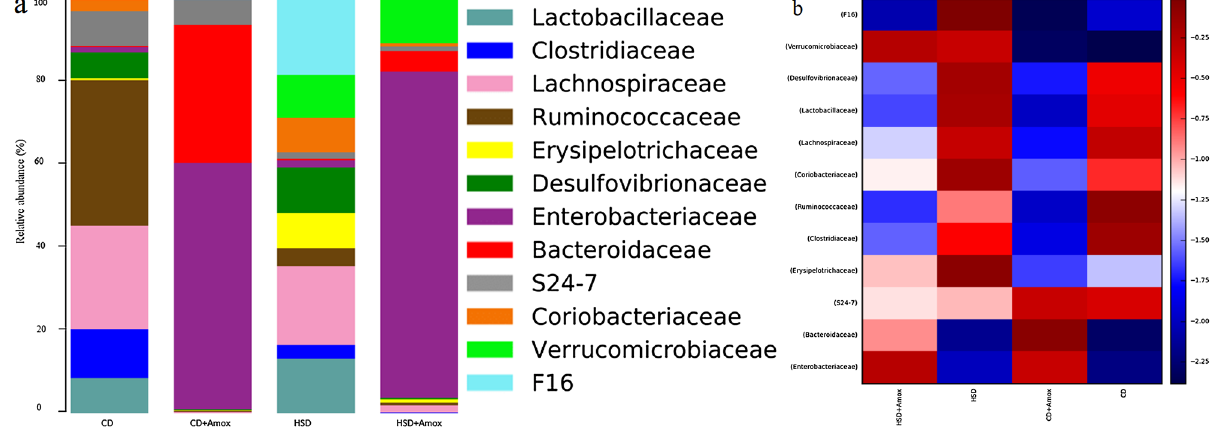
Figure 6. Bar chart ( a ) and heat map ( b ) showed the short-term effect of a high-salt diet (4% in chow) followed by Amoxicillin treatment on the relative abundance of the most represented family for each group. Amoxicillin-treatment in HSD-fed mice found a significant decrease in Erysipelotrichaceae , Desulfovibrionaceae , Coriobacteriaceae , F16 and a significant increase in Bacteroidaceae , Enterobacteriaceae and Verrucomicrobiaceae . Color heat map ( b ) analysis illustrating the top 12 mean abundances of the bacterial community taxa assigned to family. The color intensity in each sample is normalized to represent its relative ratio in the four groups. The color scale of higher (dark red) and lower (dark blue) shows the relative abundances of bacterial communities. CD: Standard—chow diet for 3 weeks; CD + Amox: Standard—chow diet for 3 weeks and subjected to Amoxicillin treatment in 3rd week; HSD: High-salt diet for 3 weeks; HFD + Amox: High-salt diet for 3 weeks and subjected to Amoxicillin treatment in 3rd